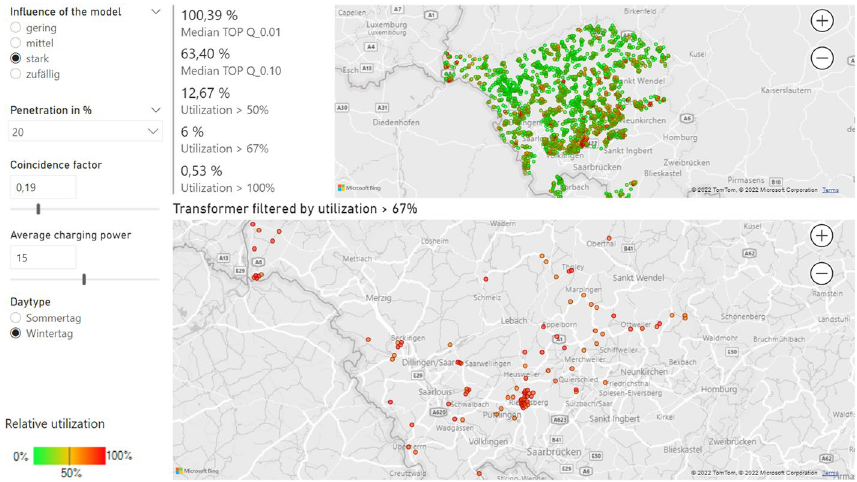
Fig. 6 Geographic evaluation of simulation